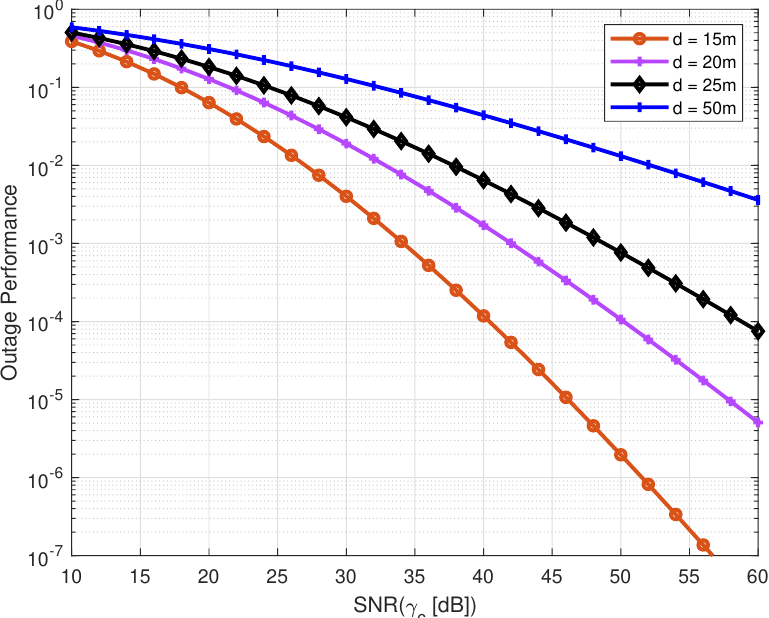
Figure 11. The combined outage performance of the system is depicted at the particular vertical distance of the communication setup in both of the oceans. The highest and minimum outage performances are depicted on different water